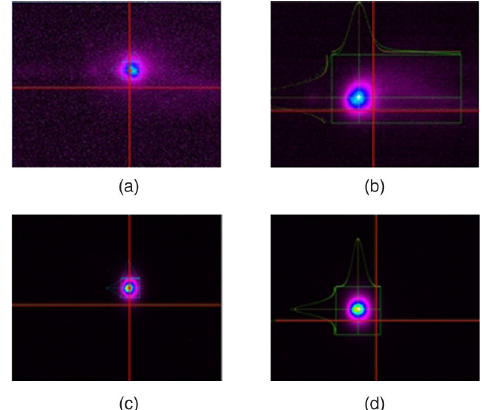
FIG. 3. Image of the LH laser [(a), (b)] and electron beam [(c), (d)] on two Chromox screen targets at the undulator entrance [(a), (c)] and exit [(b), (d)]. The red crosses indicate the center of the